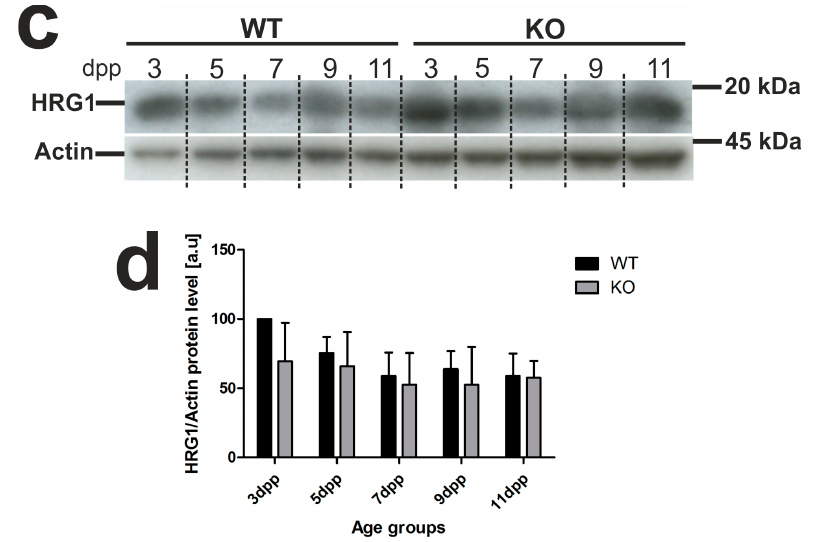
Figure 4. Heme transporter heme-responsive gene 1 (HRG1) in renal tissue. ( a ) Immunofluorescence (IF) staining of HRG1 (red channel) in the kidneys of 3 and 11 day old wild-type (WT) and heme oxygenase 1 (HO1) KO mice, analyzed by confocal microscopy. Cell nuclei were counterstained with DAPI (blue). Scale bars correspond to 20 µ m. ( b ) RT-qPCR analysis of HRG1 ( Slc48a1 ) messenger RNA (mRNA) levels in the kidneys of WT and KO mouse neonates. The graph presents relative HRG1 transcript levels in arbitrary units (means ± SD, n = 5 per group; Student t -test, NS). ( c ) HRG1 protein in kidneys assessed by Western blotting. The blots were reprobed with polyclonal anti-actin antibody as a sample loading control. Results come from four separate blots and relative levels of proteins are shown in the graph ( d ). Immunolabeled HRG1 and actin control bands were quantified using a Molecular Imager, and the relative levels of the tested proteins are plotted in arbitrary units (means ± SD, n = 4 per group; Student t -test, NS). dpp—days postpartum, NS—not significant.